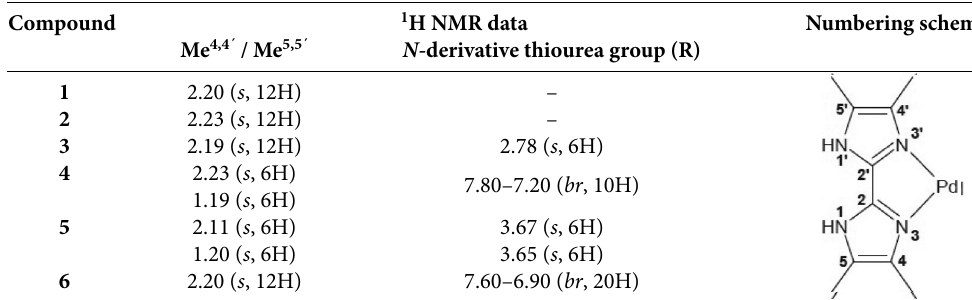
Table 2. 1 H-NMR chemical shift (ppm) for the compounds at 298 K. Compound